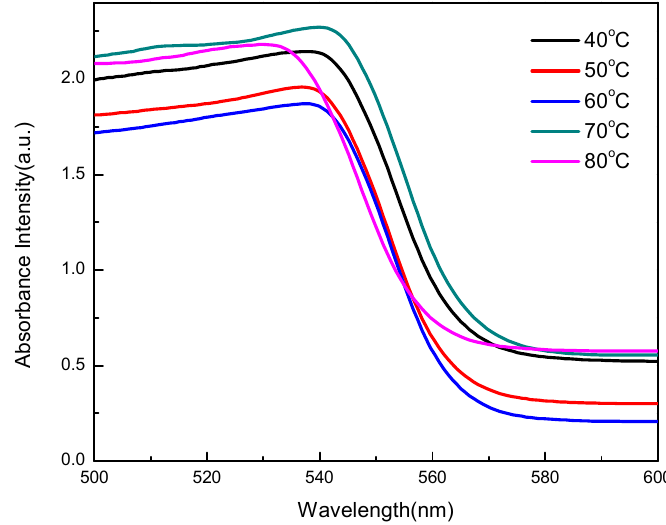
Figure 5. Absorption spectra of the MAPbBr 3 crystals prepared at various temperatures.